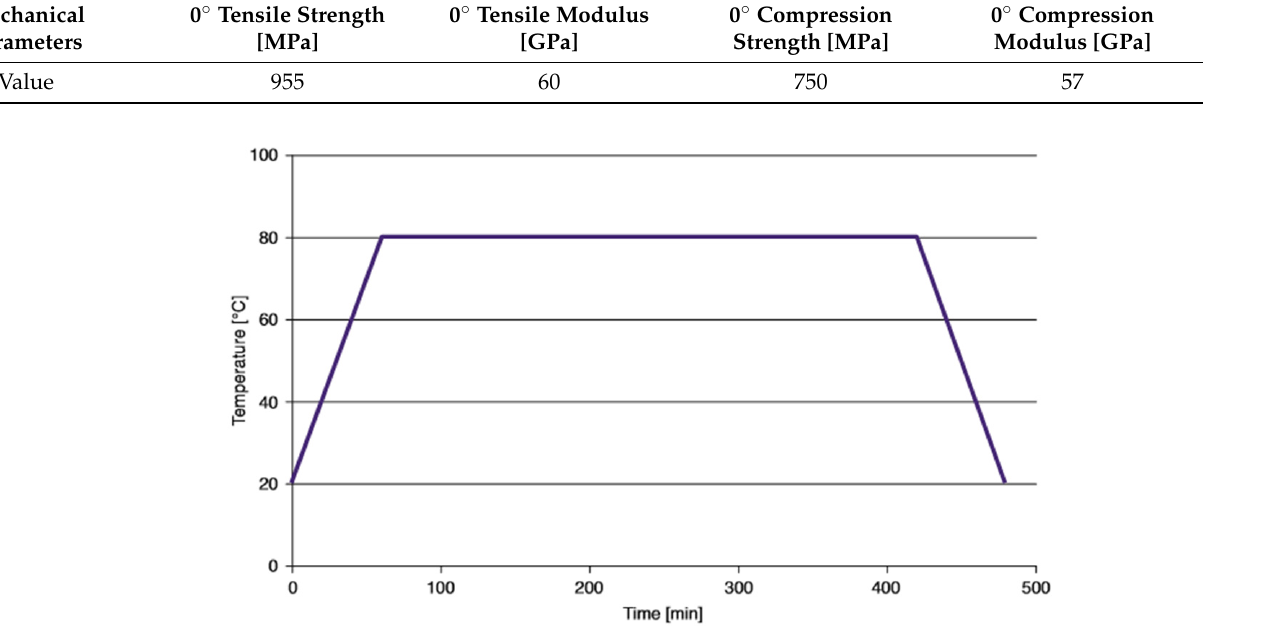
Figure 3. Typical cure cycle (HexPly ® M79, 2014).